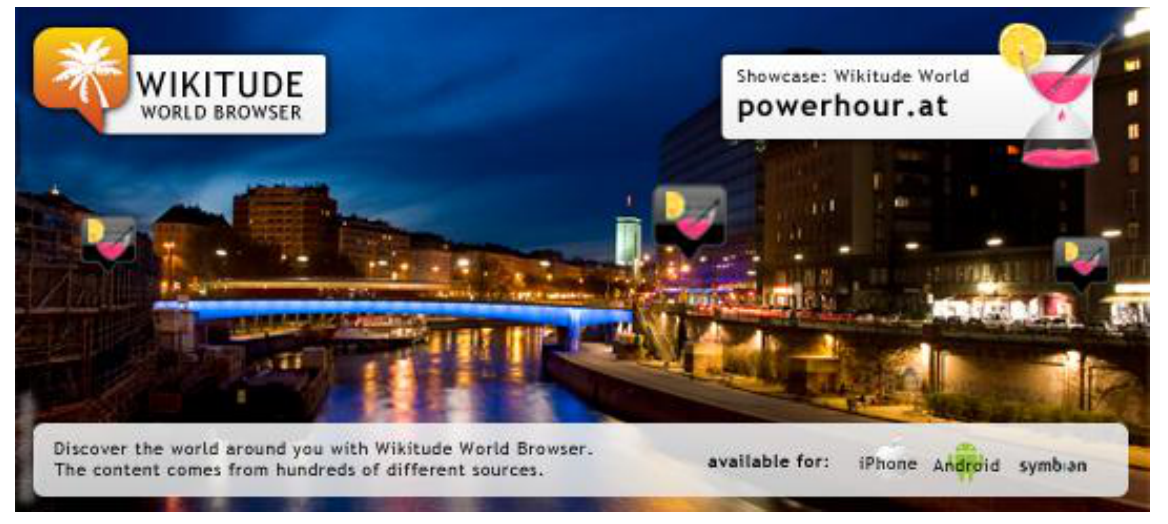
Figure 7. Wikitude World Browser illustration (from Wikitude web site